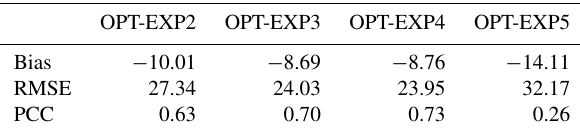
Table 7. Continuous statistics for OPT-EXP2 to OPT-EXP5.